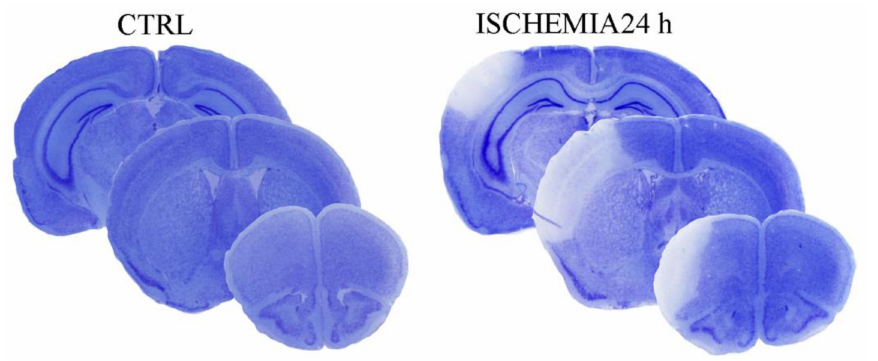
Figure 1. Representative thionine staining of the area penumbra. Representative slices stained with thionine from control ( left panel ) and ischemic mice ( right panel ). The extent of the ischemic lesion is shown in ischemic mice and the infarct volume was calculated from n = 4